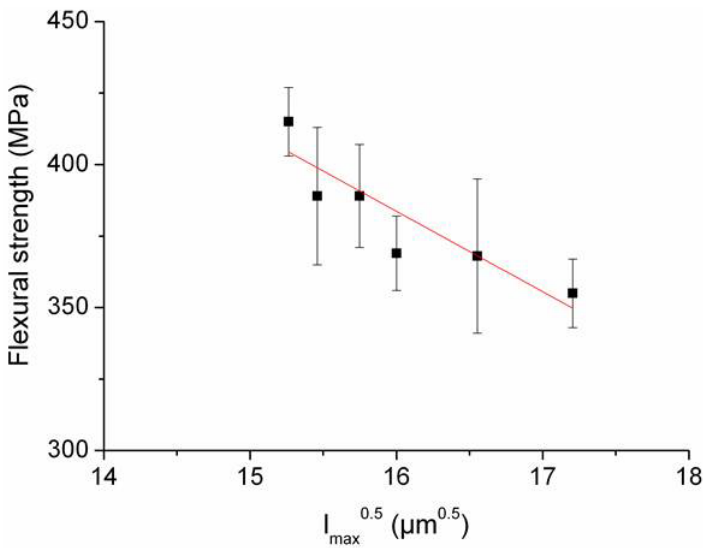
Figure 8. Strength vs. square root of maximum fiber length, considering the longest fiber as a critical